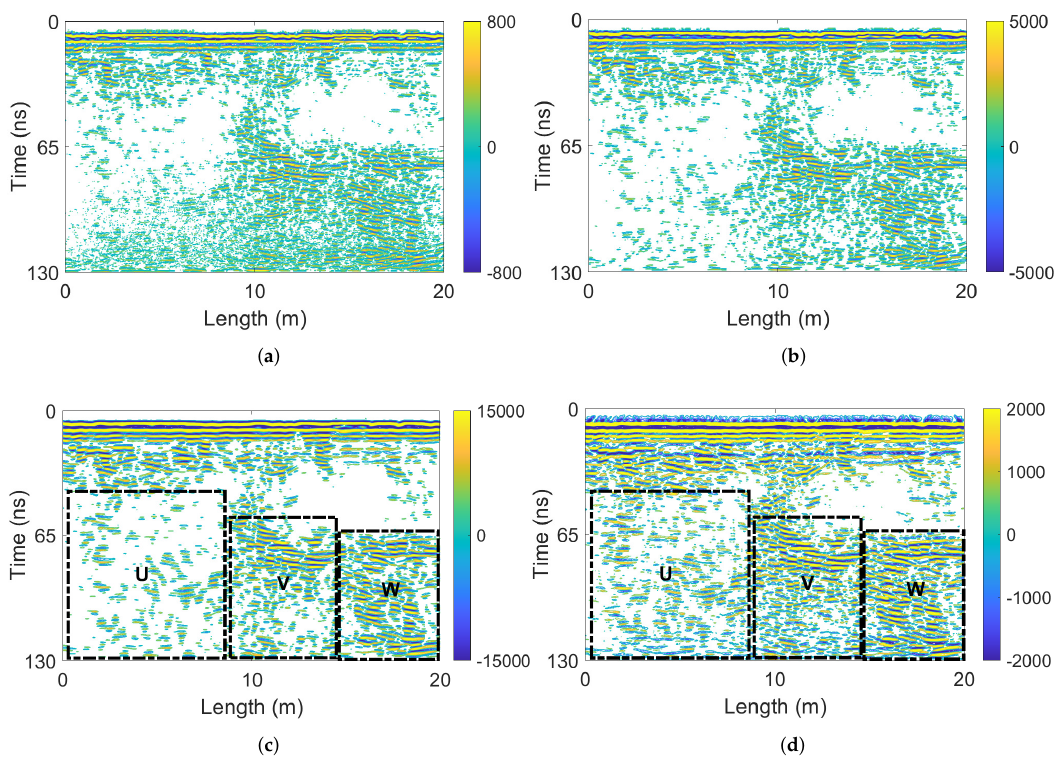
Figure 18. ( a ) F-K migration results of 1st-layer DH 1 , ( b ) 2nd-layer DH 2 , ( c ) 3rd-layer DH 3 , and ( d ) pre-processed radargram without SWT decomposition. Signals weaker than 2.5% of the maximum amplitude are